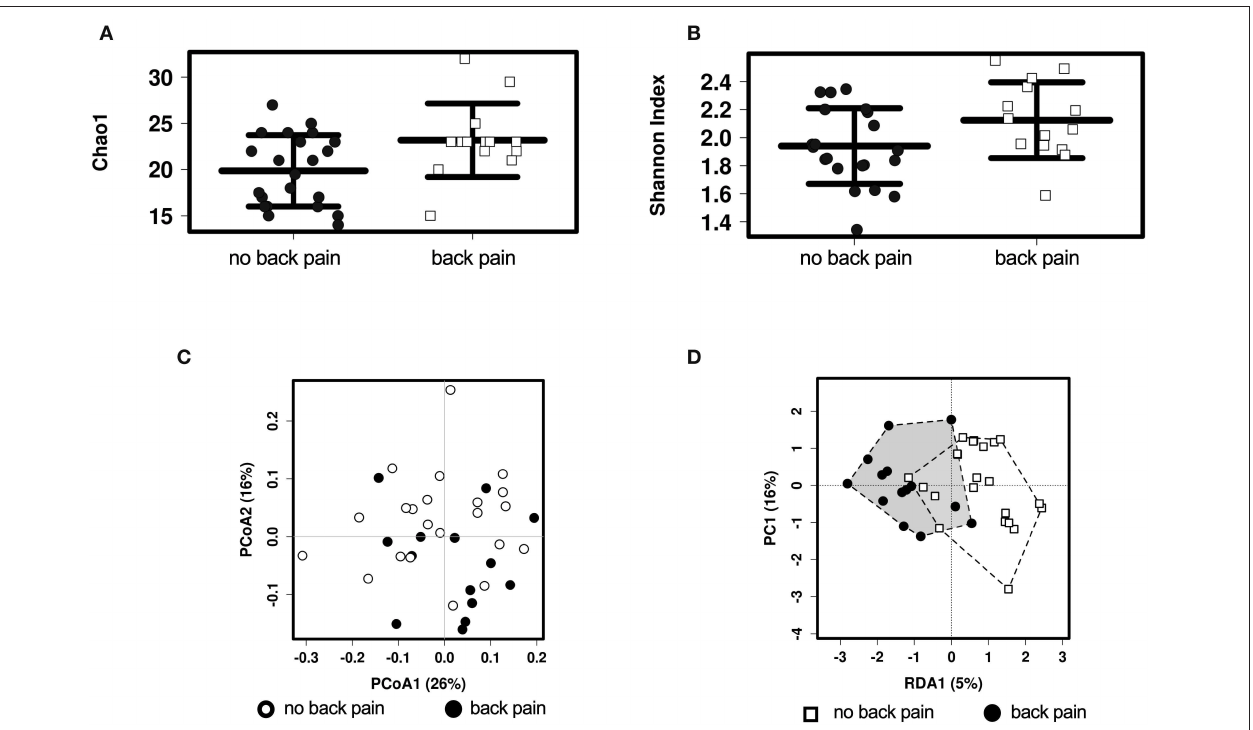
FIGURE 1 | Alpha and Beta diversity analyses of the associations between gut microbiota and back pain. Alpha diversity in individuals with and without back pain in the past month as assessed by the Chao1 (A) or the Shannon (B) index. Beta diversity as assessed by unsupervised PCoA analysis (C) and by supervised RDA analysis (D) with the black and white shapes representing individuals with and without back pain,